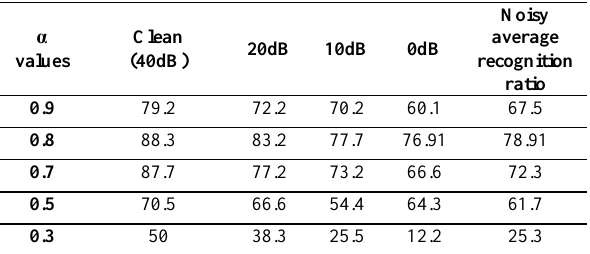
Table 2. The experiments to select the best root for using after CLMN block was performed. Results show that α=0.8 yields better speech recognition accuracy in noisy condition. The highest noisy average recognition ratio occurred in α=0.8. Noisy 20dB 10dB 0dB